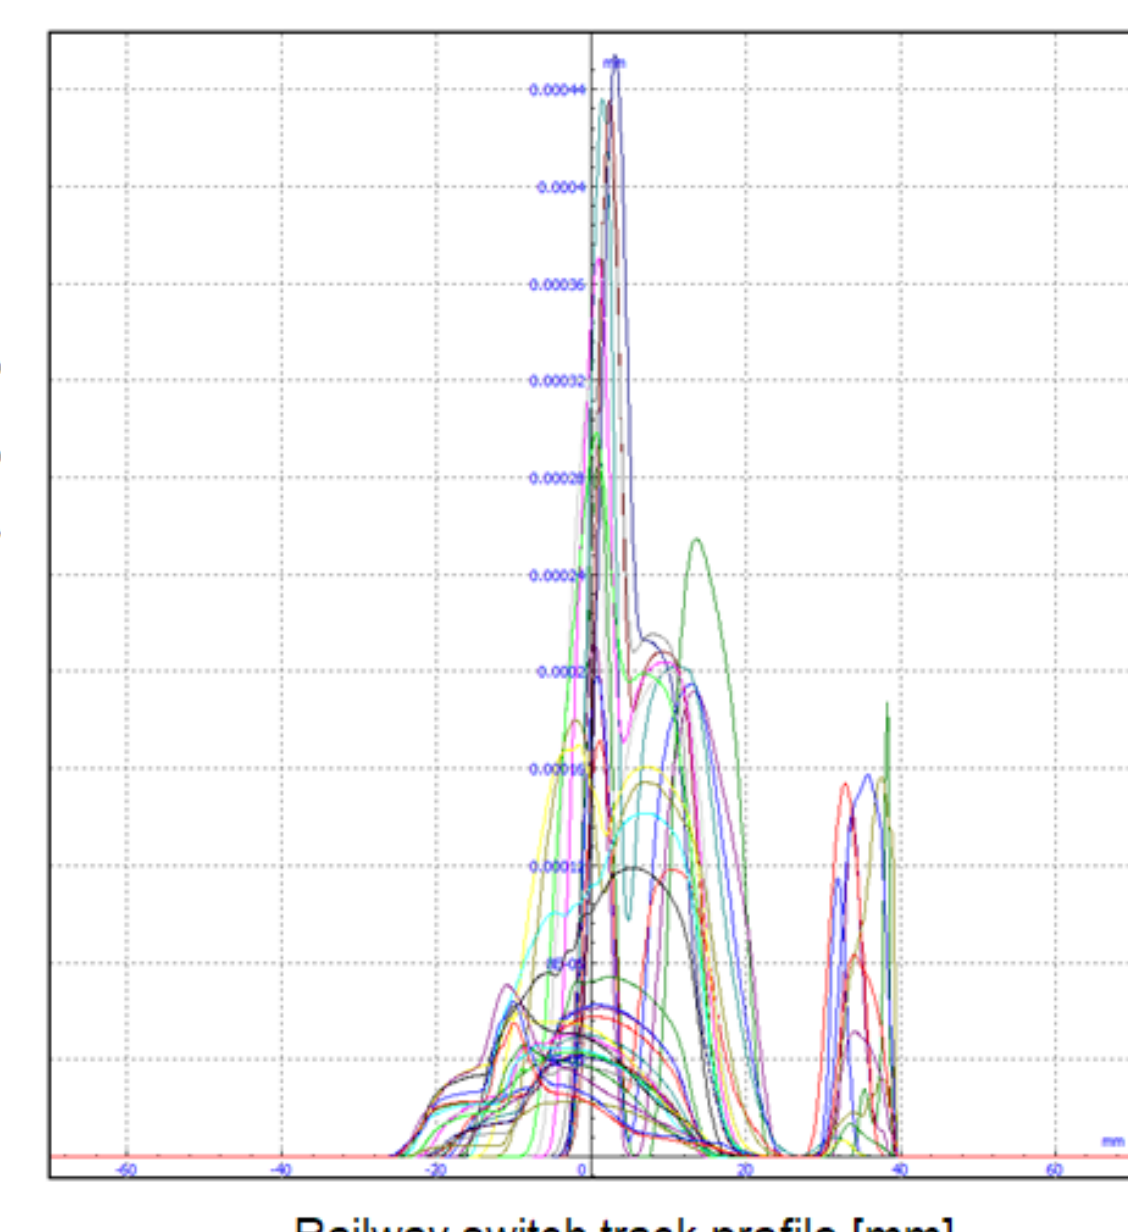
Figure 39. Wear of rail by the left wheel of the first set when the rail vehicle passes through the turnout at 200 km/h on a straight track.